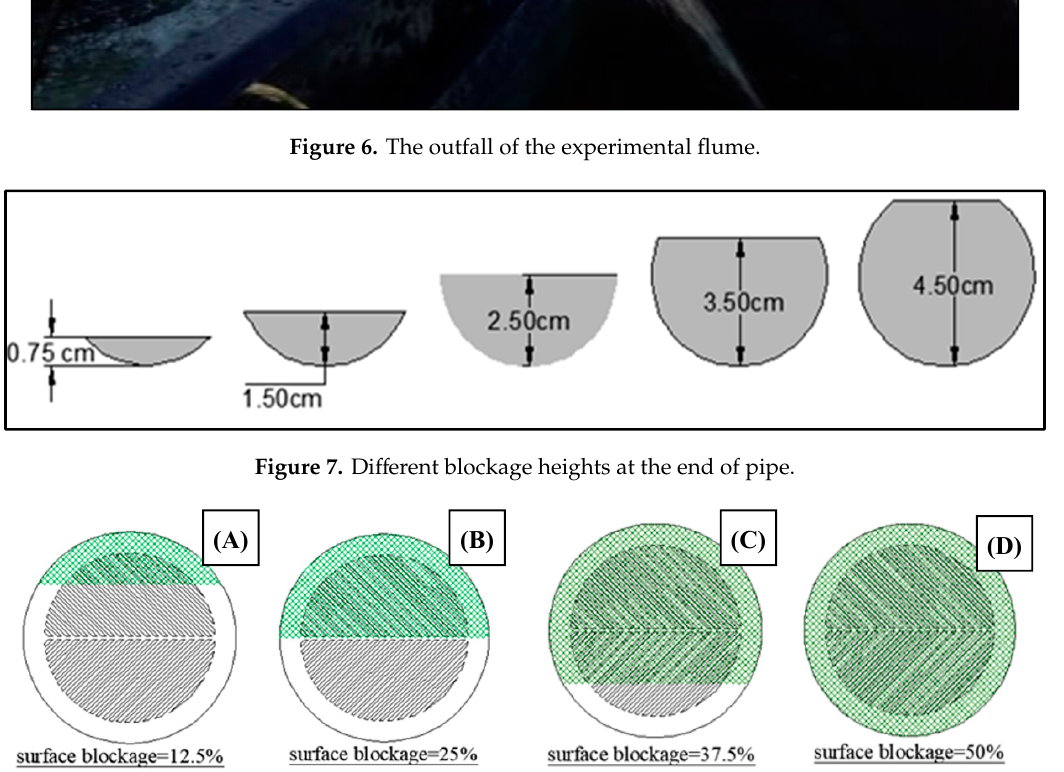
Figure 8. Di ff erent sizes of grate blockage. ( A ) surface blockage 12.50%, ( B ) surface blockage 25%, ( C ) surface blockage 37.50%, ( D ) surface blockage Figure 8. Different sizes of grate blockage. ( A ) surface blockage 12.50%, ( B ) surface blockage 25%, Figure 8. Different sizes of grate blockage. ( A ) surface blockage 12.50%, ( B ) surface blockage 25%, Figure 8. Different sizes of grate blockage. ( A ) surface blockage 12.50%, ( B ) surface blockage 25%, ( C ) surface blockage 37.50%, ( D ) surface blockage 50%, ( C ) surface blockage 37.50%, ( D ) surface blockage 50%, ( C ) surface blockage 37.50%, ( D ) surface blockage 50%,